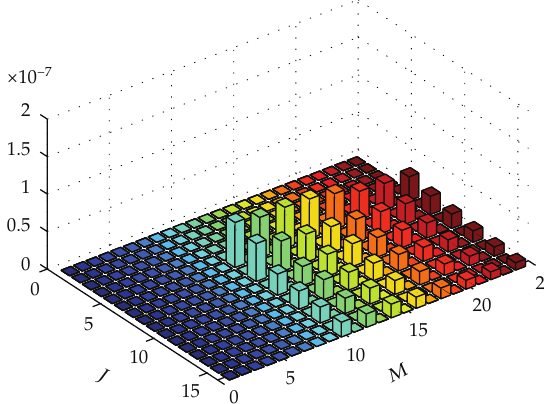
Figure 9: Maximum error variation for J and M .